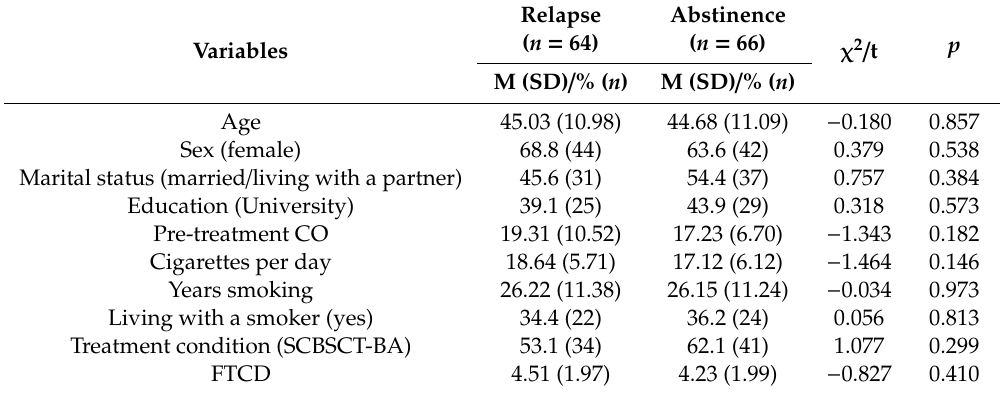
Table 1. Sociodemographic and smoking-related variables according to smoking status at the 3 month